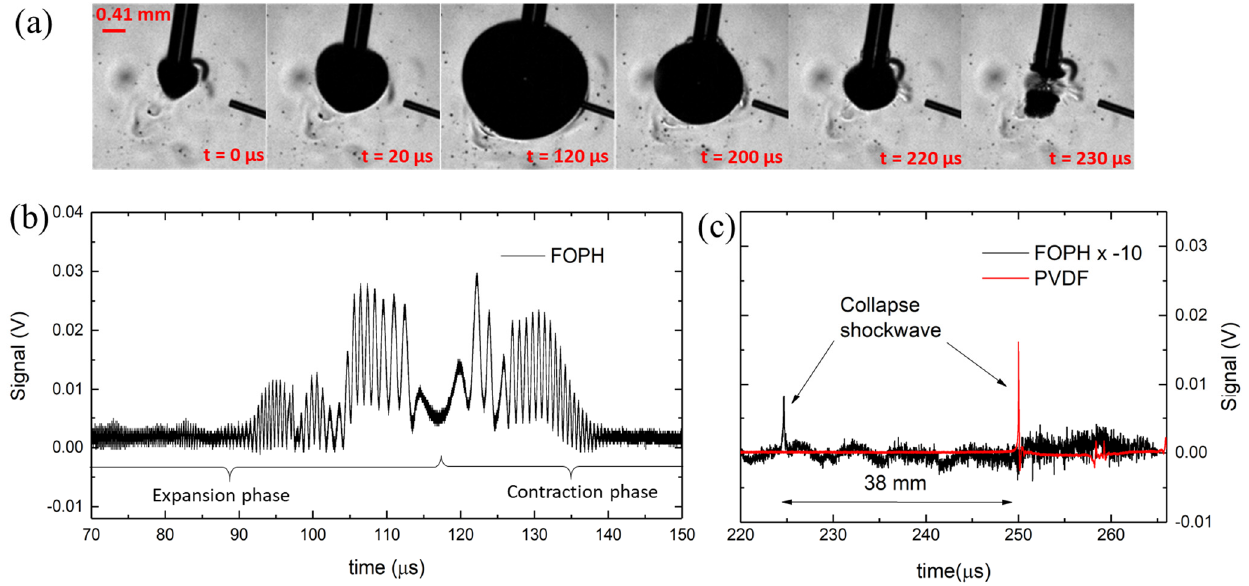
Figure 3. ( a ) Typical bubble dynamics upon laser irradiation through vertically oriented fiber tip; ( b ) single-shot measured signal with FOPH (black line), with visible interferometric fringes at earlier acquisition time; ( c ) average of 50 measured signals with FOPH, where the pressure-induced spike resulting from the shock wave impact with the optical fiber is visible. The signal recorded with the PVDF hydrophone needle is shown in red. In all graphs, the time origin is at the initialization of the bubble, shown in ( a ) at t = 0 μ s.